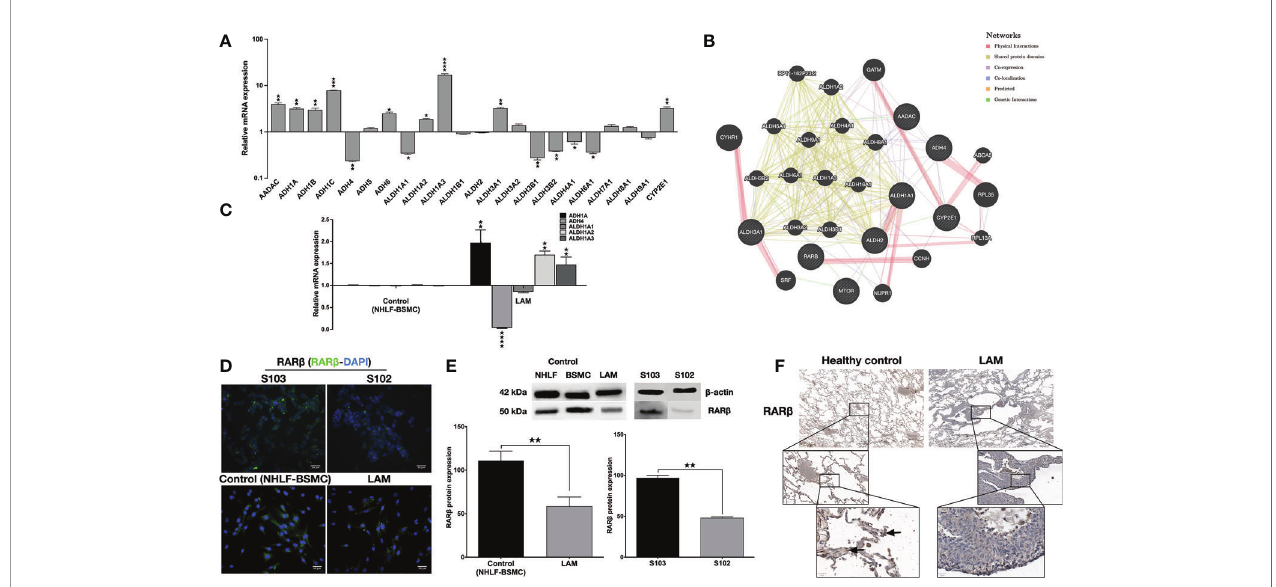
FIGURE 1 | Metabolic enzyme and retinoic acid receptor expression. (A) Human metabolic enzyme RT array analysis of S102 (TSC2-/-) compared to S103 (TSC2 +/+) control. The fi gure presentsLog RQ± technical errorof n=3 replicates (t-test). (B) Predictive analysis of co-expression, physical interactions between metabolic enzymes and RA in TSC mutant diseases groups using GeneMANIA database. (C) Gene expression of enzymes involved in vitamin A metabolism measured in LAM cell lines compared to primary healthy controls (BSMC and NHLF, 1:1). Data are presented as mean LogRQ ± SEM compared to untreated control. Signi fi cant changes are marked as ★ , ★★ , ★★★ and ★★★★ (P<0.05, P<0.001, P<0.0002 and P<0.0001, respectively). (D) RAR b immuno fl uorescent staining (RAR b green, nuclei blue, magni fi cation ×40, size bar 28-40 m m). (E) Western blot analysis of RAR b protein levels in LAM, control (NHLF and BSMC), S103 and S102 cell lines. WB protein expression levels were quanti fi ed by ImageJ and are presented as percentage compared to controls or S103. Signi fi cant changes are marked as ★ , ★★ and ★★★ (P<0.05, P<0.001 and P<0.0002 respectively). (F) RAR b immunohistochemistry of a representative pair of primary LAM lung sections and healthy lung controls (size bar 100-500 m m),